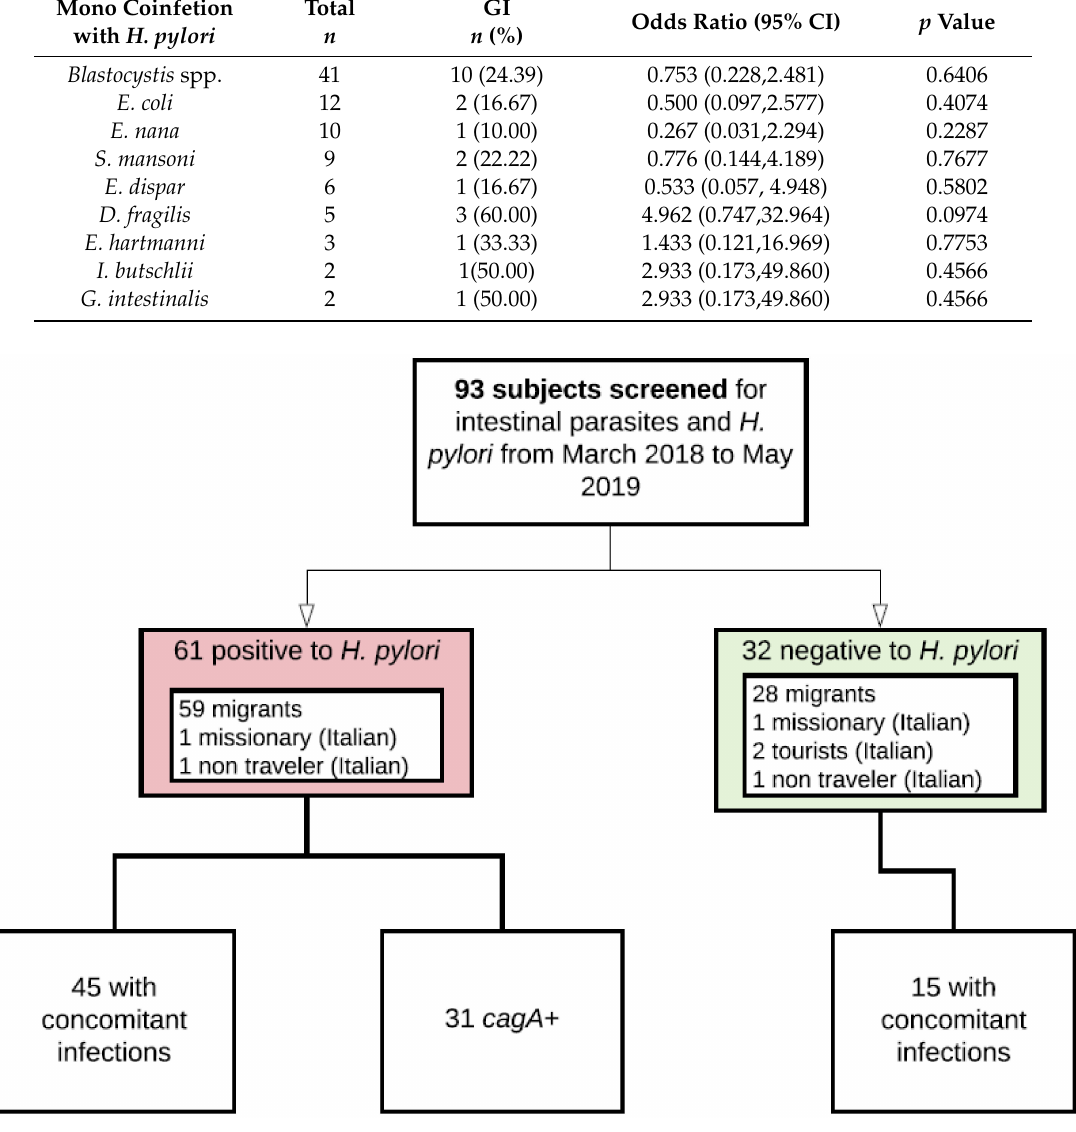
Figure 1. Study flow